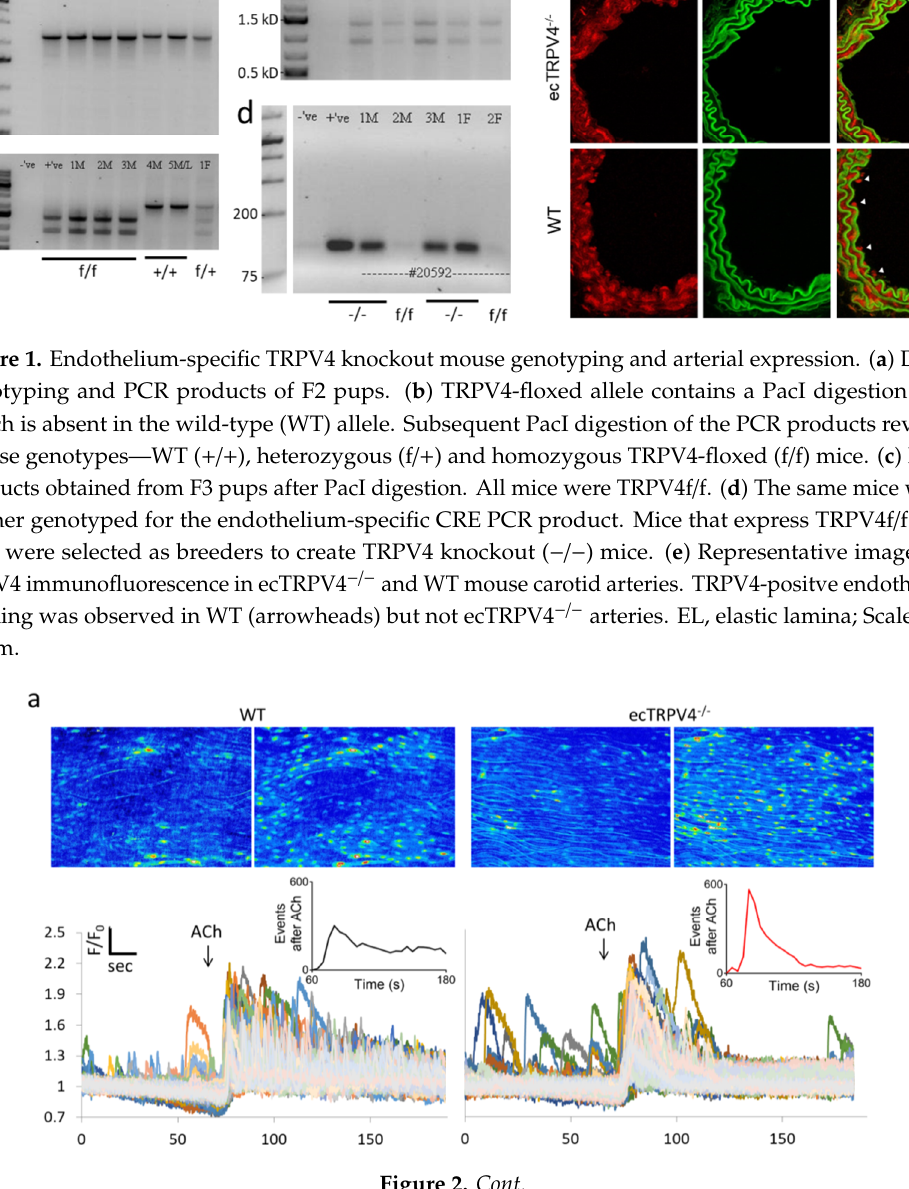
Figure 1. Endothelium-specific TRPV4 knockout mouse genotyping and arterial expression. ( a